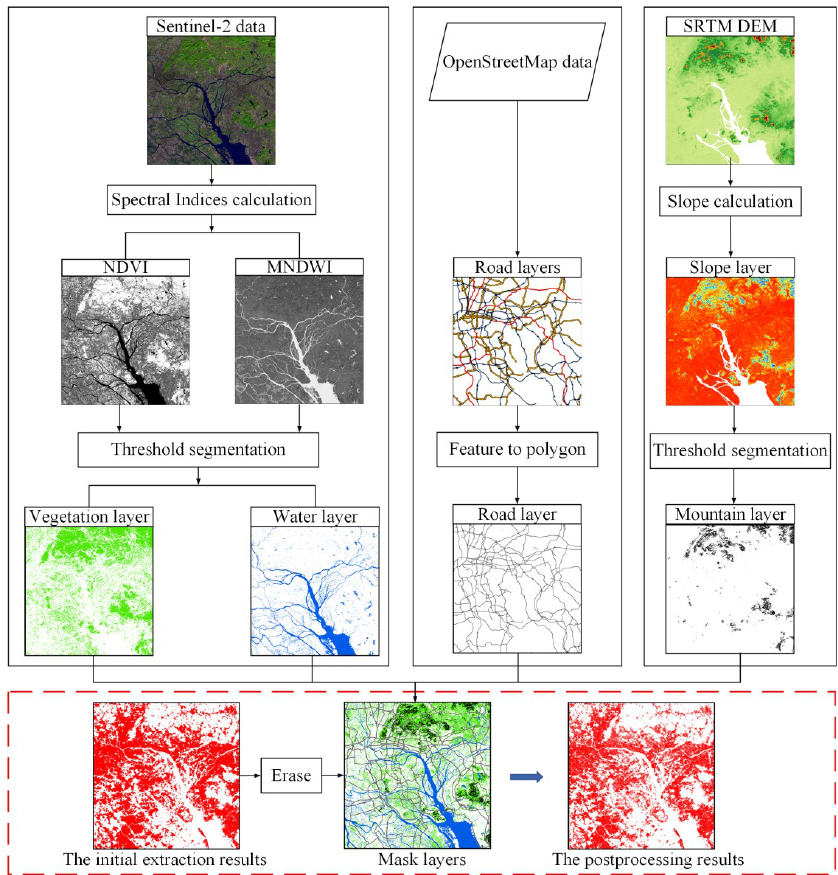
Figure 5. Framework of postprocessing process.